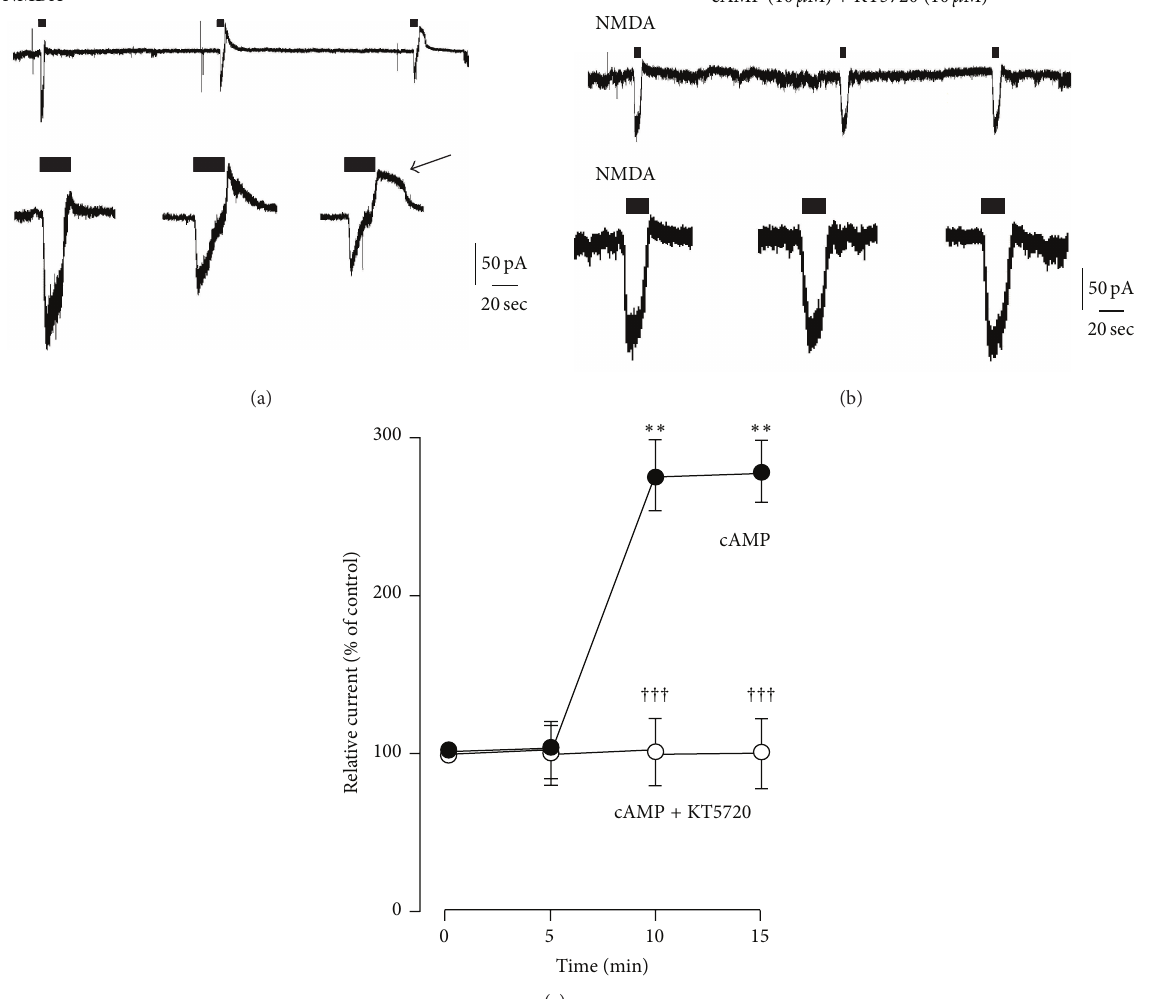
Figure 2: Cyclic AMP/PKA pathway facilitates NMDA-induced outward current in the acutely dissociated mouse cortical neurons. (a, b) Intracellular perfusion of cAMP (10 𝜇 M) facilitated NMDA-induced outward currents (a), whereas KT5720 (10 𝜇 M), a specific inhibitor of PKA, abolished them (b). Upper trace is continuous recording of NMDA-induced currents. Lower traces are enlarged traces of upper trace. An arrow indicates the prolonged NMDA-induced outward current. Calibration bars are 50 pA and 20 sec applicable to lower traces. (c) Time course of the potentiation of NMDA-induced outward currents by intracellular perfusion of cAMP. The circles and bars represent the mean ± SEM ( 𝑛 = 4 cells). Asterisks indicate a significant difference from the none-treated control ( ∗∗ 𝑃 < 0.01 , one-way ANOVA with post hoc Dunnett’s test). Swords indicate a significant difference between cAMP and cAMP+KT5720 ( ††† 𝑃 < 0.01 , 𝐹 1,24 = 39.32, two-way ANOVA Bonferroni